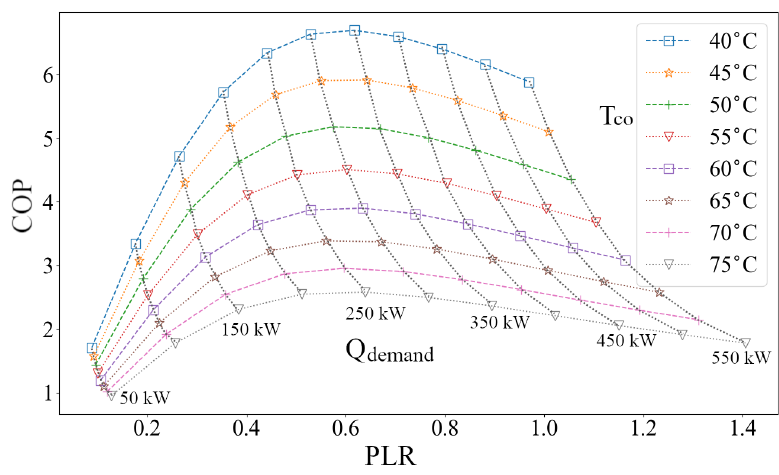
Figure 5. Performance map of the GSHP